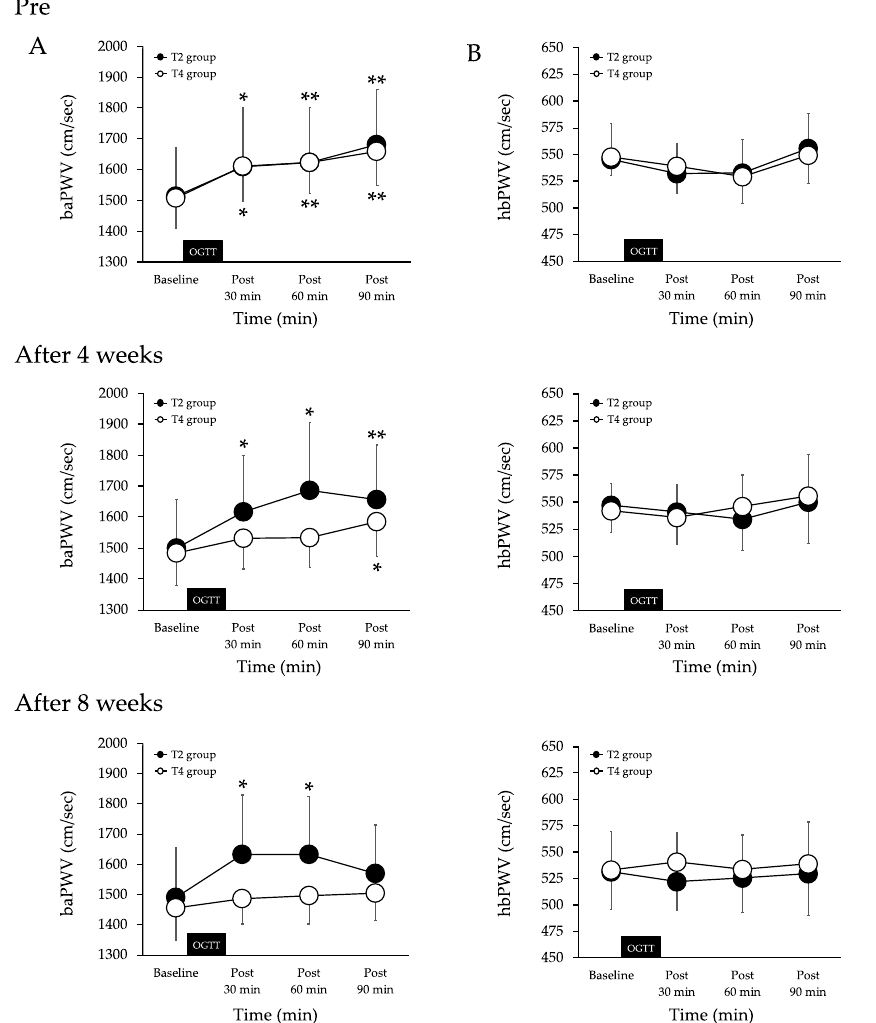
Figure 2. Changes in systemic ( A ) and proximal aortic stiffness ( B ) baseline and after the 75 - g - OGTT in both groups. Values are mean ± SD. baPWV, brachial-ankle pulse wave velocity. hbPWV, heart-brachial pulse wave velocityT2 group, aerobic exercise training twice a week. T4 group,